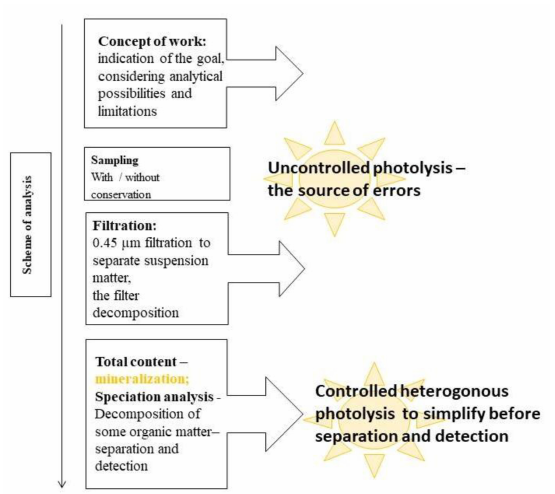
Figure 1. Scheme of ultra-trace speciation analysis of water in the context of